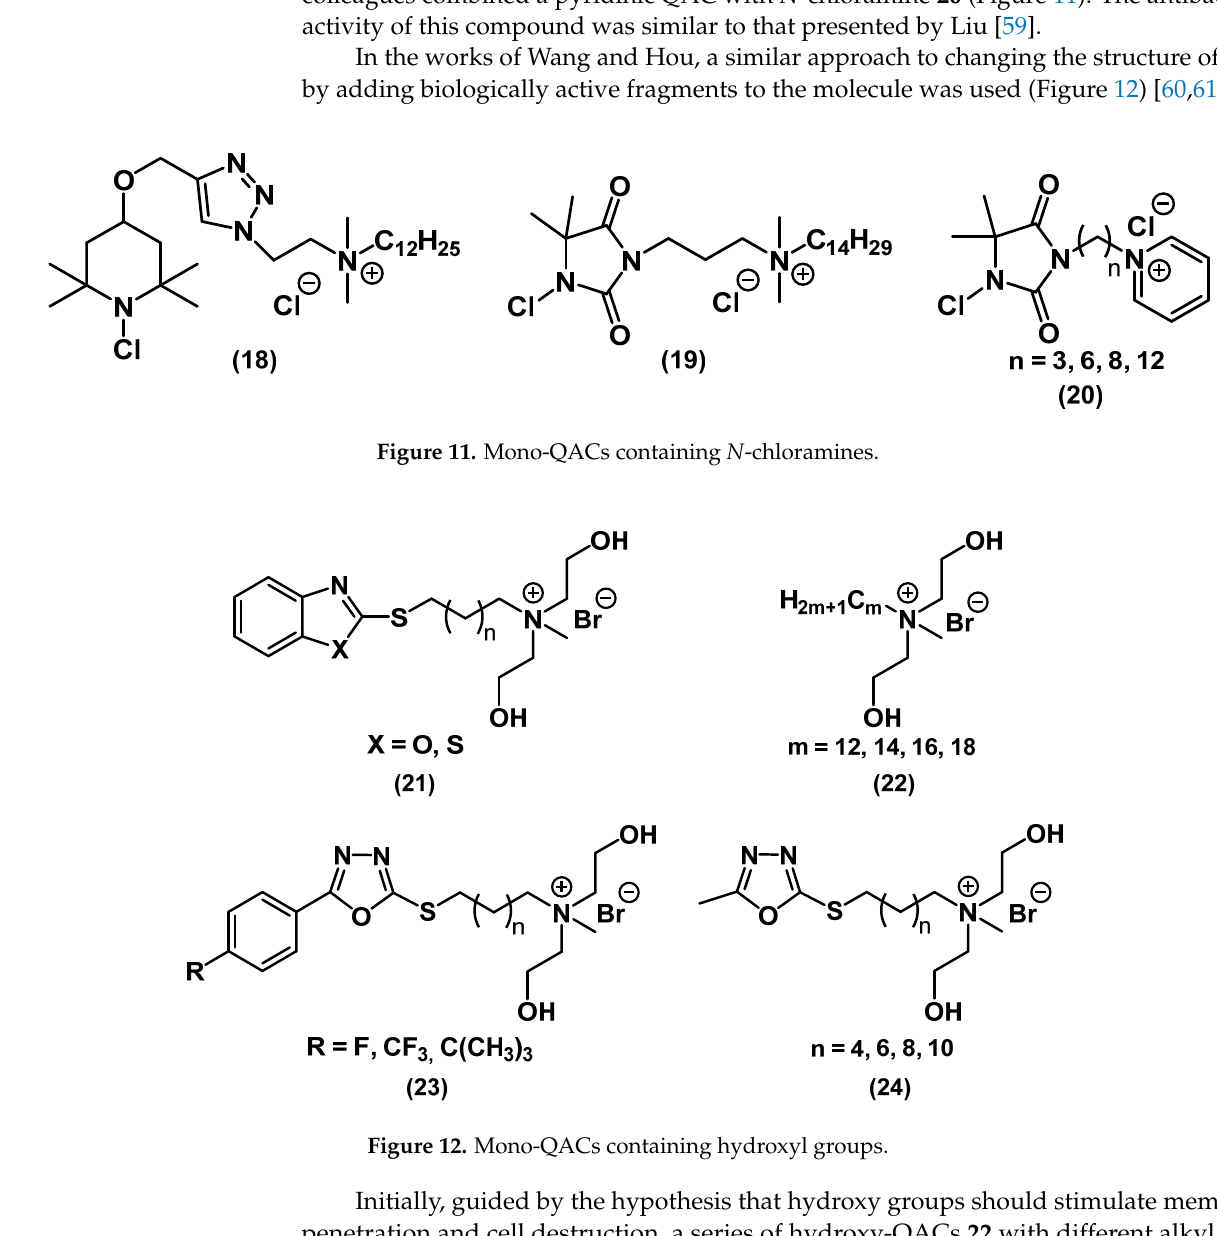
Figure 12. Mono-QACs containing hydroxyl groups.